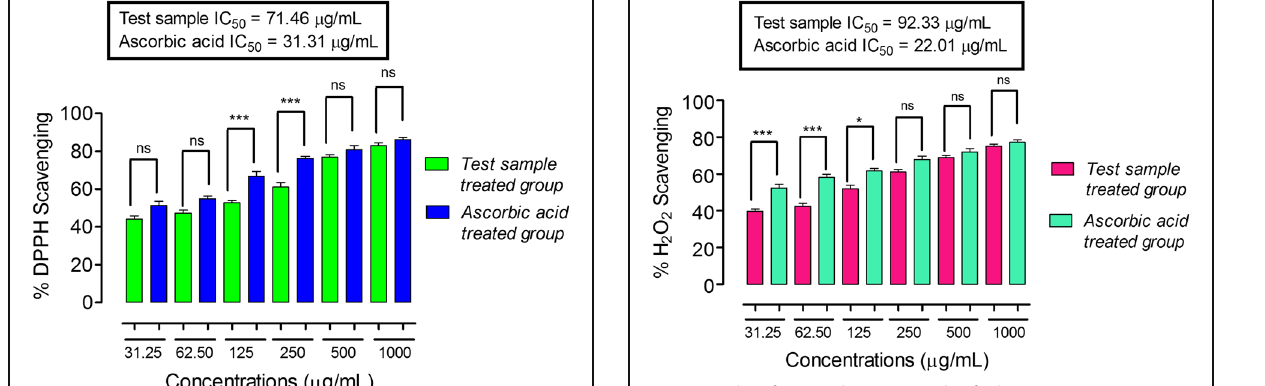
Fig. 5 Results of antioxidant potentials of Olax nana using H 2 O 2 anti-radicals assay. Values significantly different in comparison to the positive control at the same concentration i.e. *** P < 0.001, ** P < 0.01, ns: values not significantly different in comparison to % inhibition of the positive control ( P > 0.05) at the same concentration. One-way ANOVA followed by Bonferroni ’ s multiple comparison post hoc